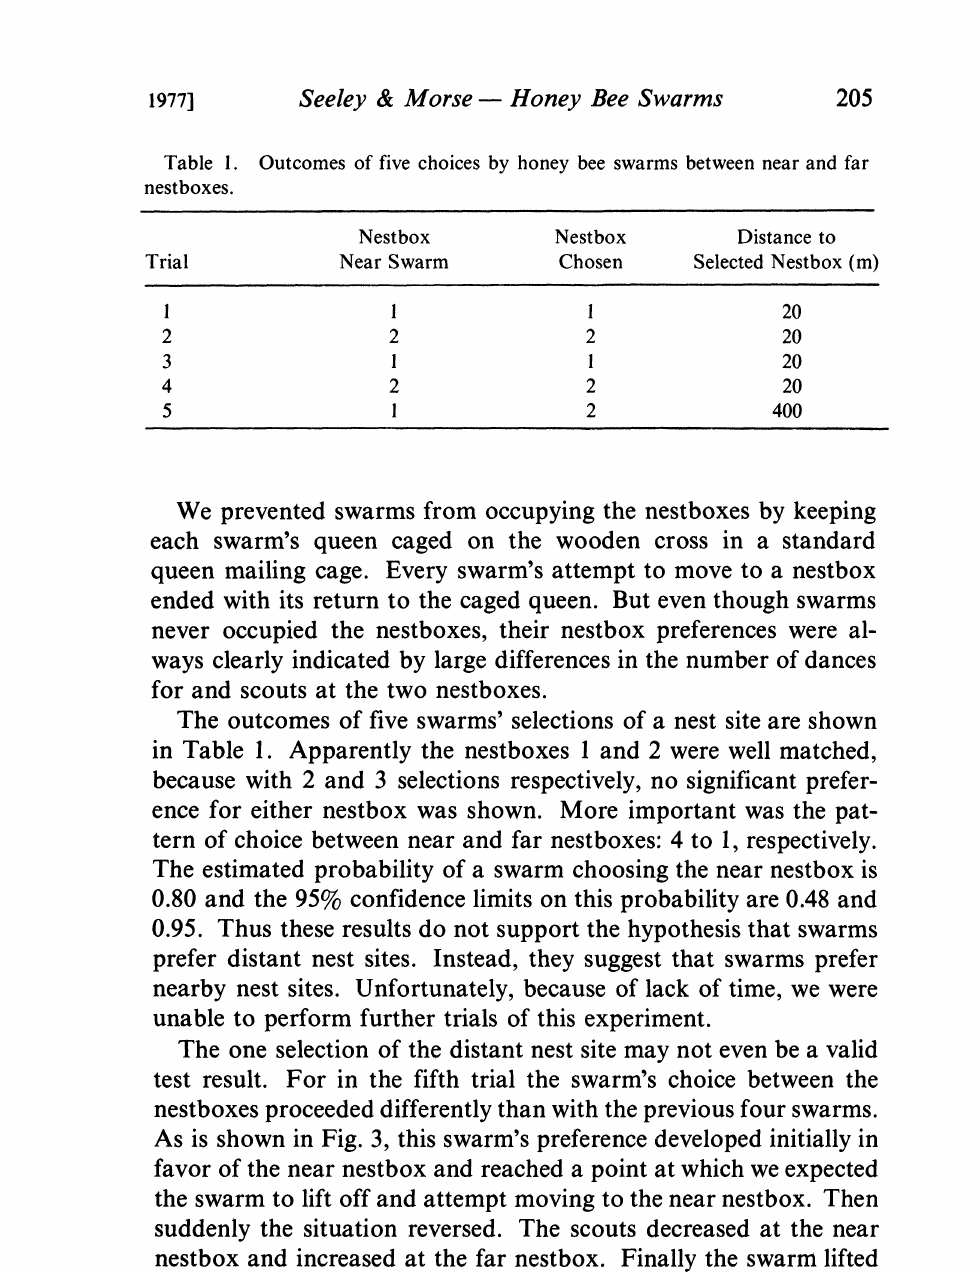
Outcomes of five choices by honey bee swarms between near and far Table 1. nestboxes. Nestbox Nestbox Distance to Trial Near Swarm Chosen Selected Nestbox